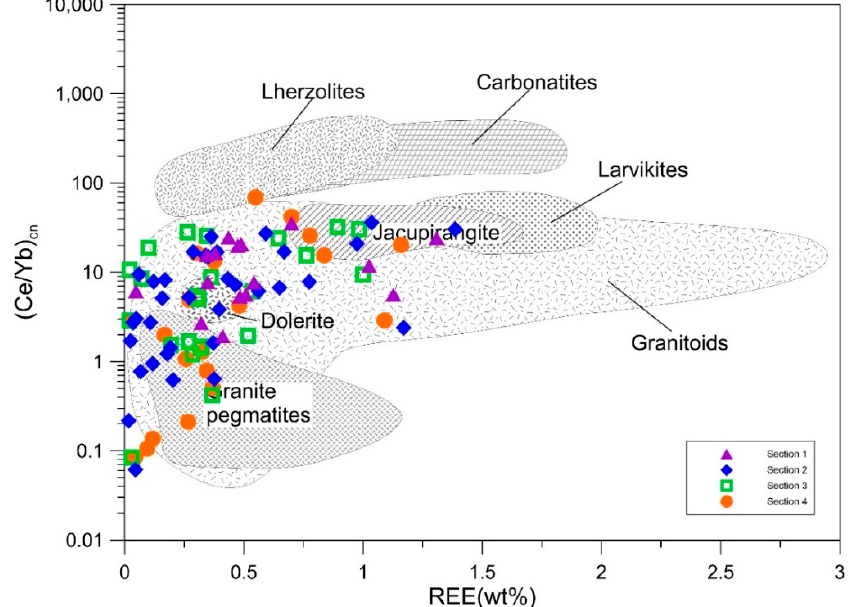
Figure 7. (Ce/Yb) cn vs. Σ REE genetic plot proposed by Reference [20], showing the analyzed apatite compositions in the four sections of Core S3 from the SOT.